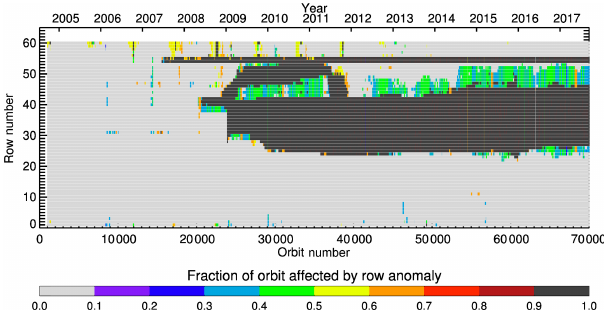
Figure 1. Temporal evolution of the row anomaly as a function of orbit number (bottom) and year (top). The color scale indicates the fraction of orbit impacted by the anomaly.